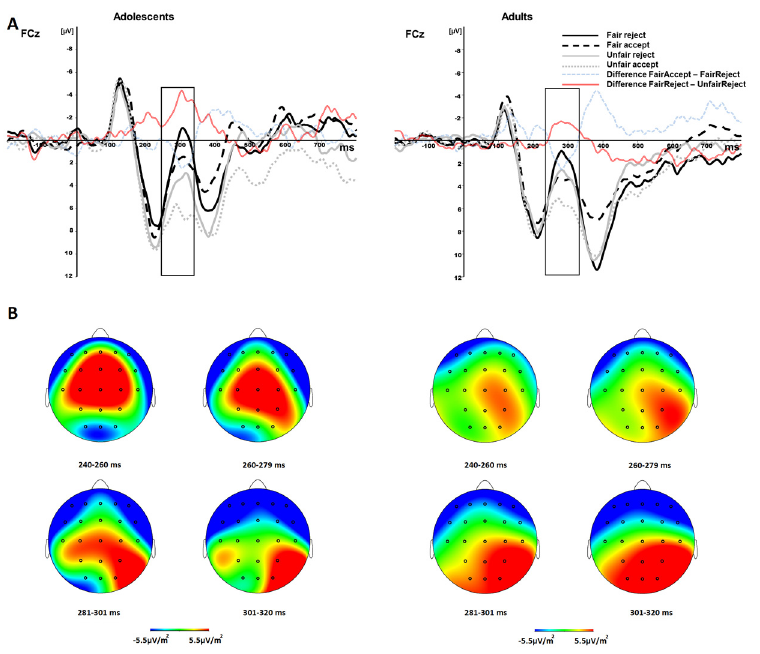
Fig 3. MFN amplitudes to acceptance or rejection of offers. MFN measured in the proposer after receiving feedback whether an offer is accepted or rejected. The horizontal axis shows time in milliseconds and vertical axis the electric potential in micro volt. Panel A reflects the MFN amplitudes (highlighted as the time-interval between 220 – 320 ms) for proposers after making fair and unfair offers. The MFN amplitudes for fair offers are plotted in black, while unfair offers are plotted in grey. The solid lines reflect MFN amplitudes after receiving feedback that an offer was rejected, while dashed lines reflect amplitudes after receiving feedback that an offer was accepted. Negative voltages are plotted upwards. In panel B the scalp potential topography is shown for the time point of the MFN (240 – 320 ms) after receiving feedback signaling whether an offer was accepted or